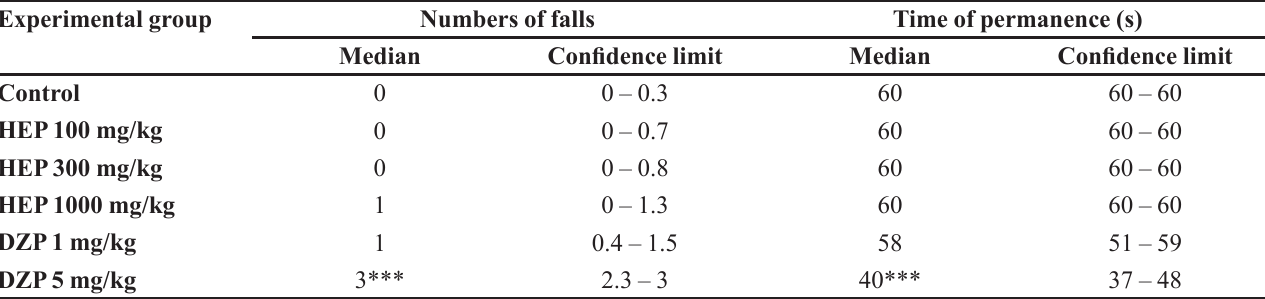
TABLE II - Effects of hydroalcoholic extract from Lafoensia pacari (HEP) on the rota-rod test, 60 minutes after treatments Experimental